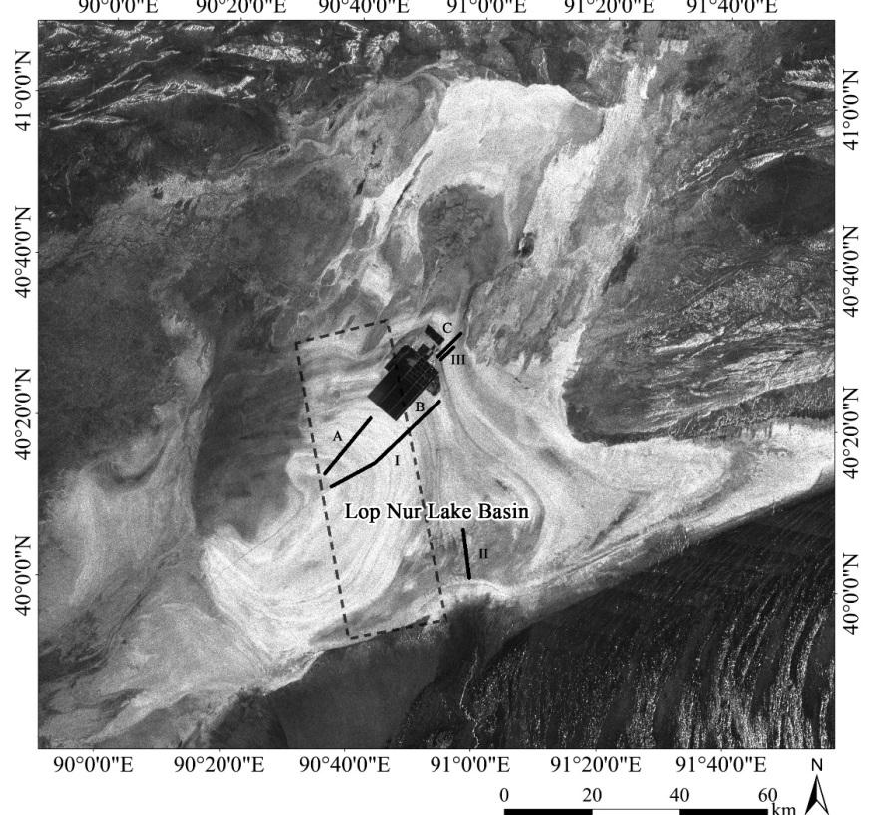
Figure 1. Field investigation routes and sampling site locations. A, B and C are field routes in 2006, and I, II and III are field routes in 2008. The dashed rectangle is the coverage of full-polarimetric SAR data used in the last part of this paper. There is a large salt pond in the middle of the image as a black square. ALOS-PALSAR image (HH polarization, ScanSAR mode) obtained on 15 January 2011 were used as base